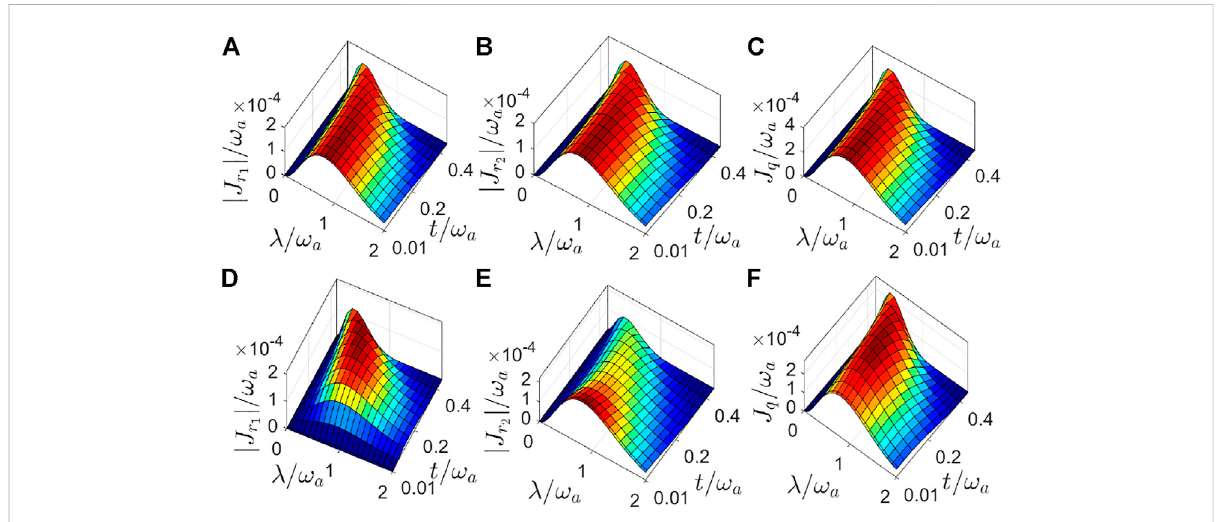
FIGURE 5 (Color online) Steady-state heat currents as functions of qubit-resonator ( λ / ω a ) and resonator-resonator ( t / ω a ) coupling strengths. We obtain (A – C) at ω ω ω a and (D – F) at ω 1 = 2 = T r = 1.5 ω a , and T q = 0.5 ω a